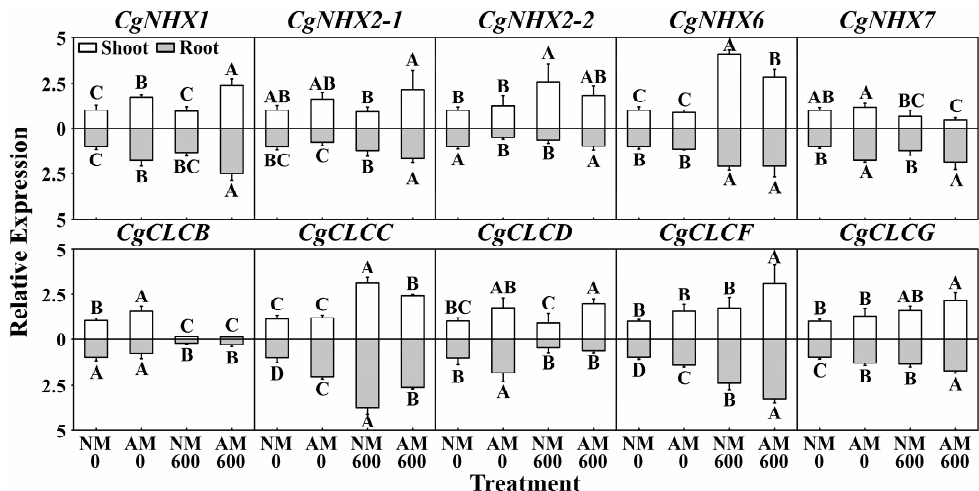
Figure 5. Effects of NaCl stress and R. irregularis inoculation on the expression of CgNHXs and CgCLCs in shoots and roots. NM, nonmycorrhizal; AM, inoculated with R. irregularis ; 0, no NaCl stress; 600, 600 mM NaCl stress. Different capital letters indicate significant differences between means at the p < 0.05 level by Tukey’s test.